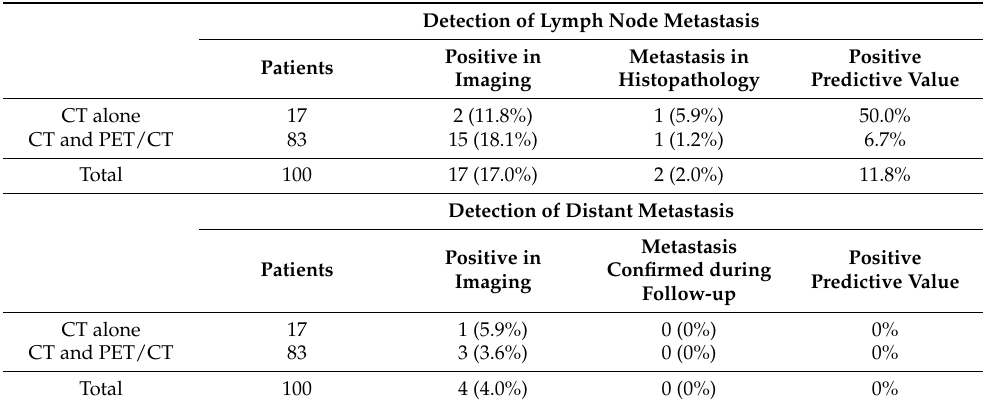
Table 2. Detection of lymph node and distant metastasis in 100 patients without lymphadenopathy.